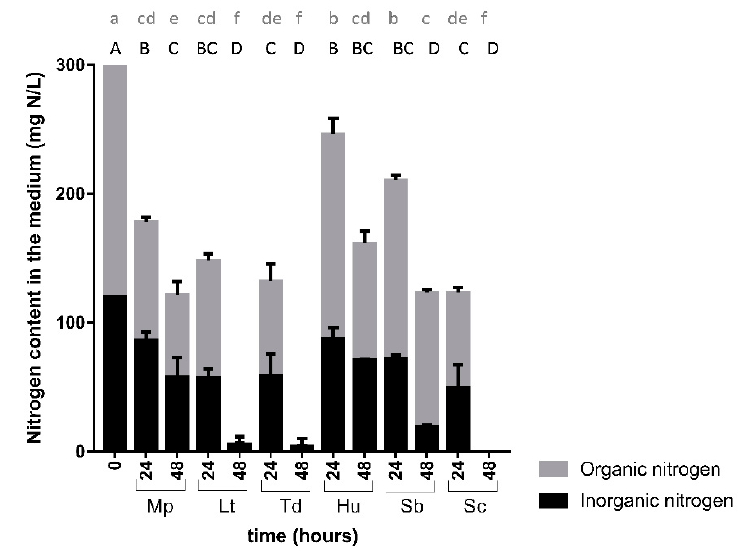
Figure 4. Organic and inorganic nitrogen (mg N/L) present in the medium at 0, 24, and 48 h during single fermentations in SM-Mix. Capital letters indicate significant differences in inorganic nitrogen levels. Lowercase letters indicate significant differences in organic nitrogen levels.